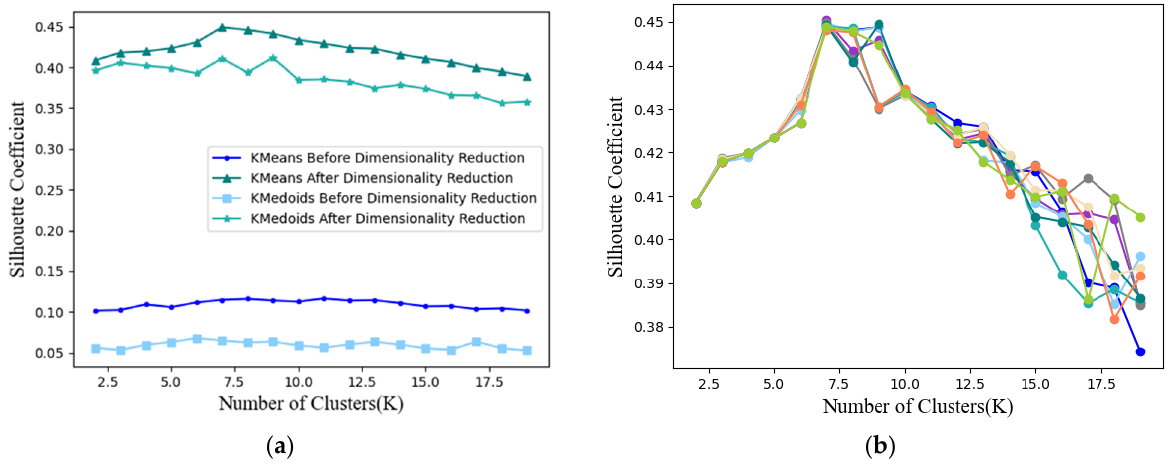
Figure 6. ( a ) Silhouette coefficient variation of different clustering methods; ( b ) Silhouette coefficient variation of k-means method after dimensionality reduction, and different colors represent different scenarios.